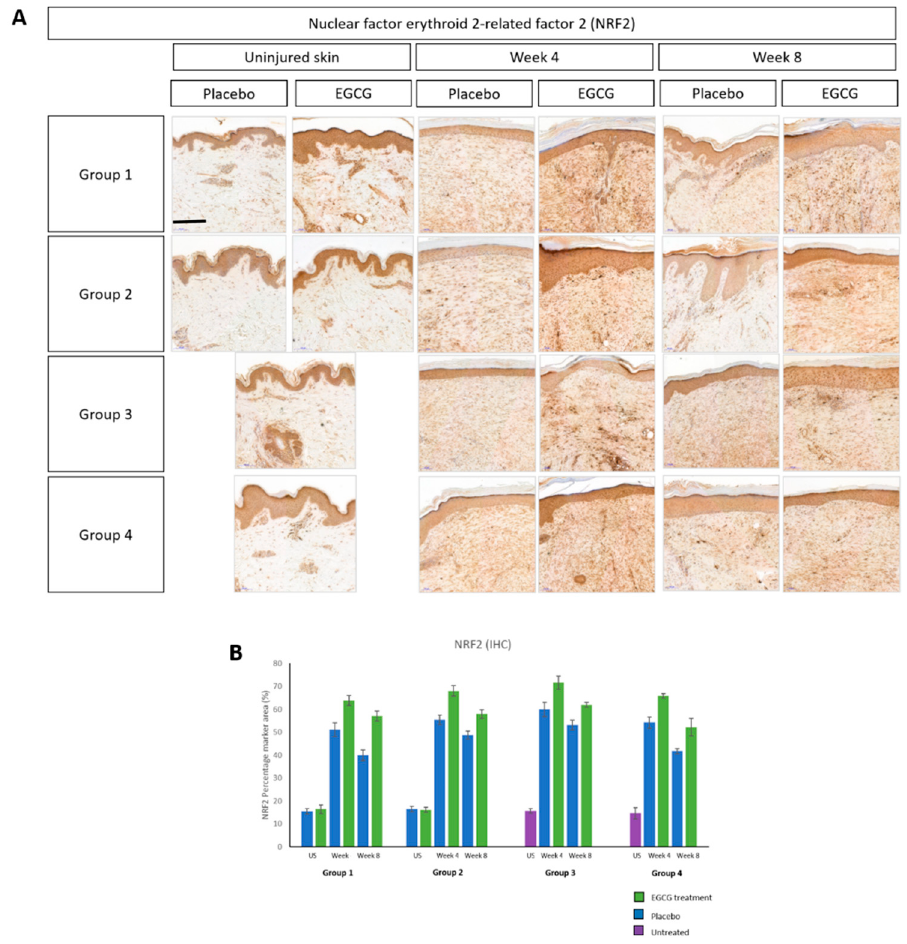
Figure 20. Antioxidant Nuclear factor erythroid 2-related factor 2 (NRF2) effects of topical epigallocatechin-3-gallate (EGCG) versus placebo. ( A ) NRF2 immunohistochemical stain images. ( B ) NRF2 percentage marker area measurements. Scale bars = 100 μ m. Error bars: mean ± SD. Significance: ★ p ≤ 0.01.